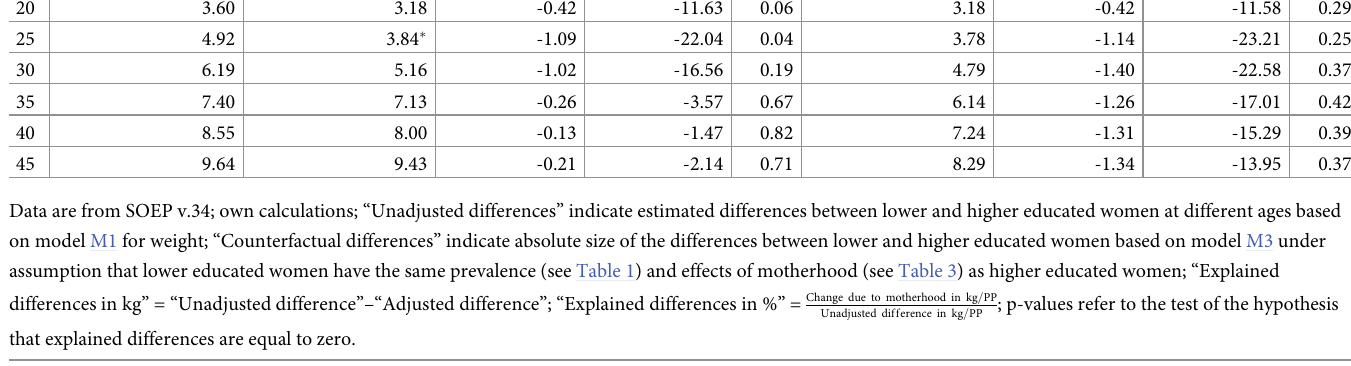
Table 4. Counterfactual analysis of change in educational difference in body weight due to differences in the prevalence and vulnerability to motherhood. Prevalence Prevalence and Vulnerability Age Unadjusted differences in kg